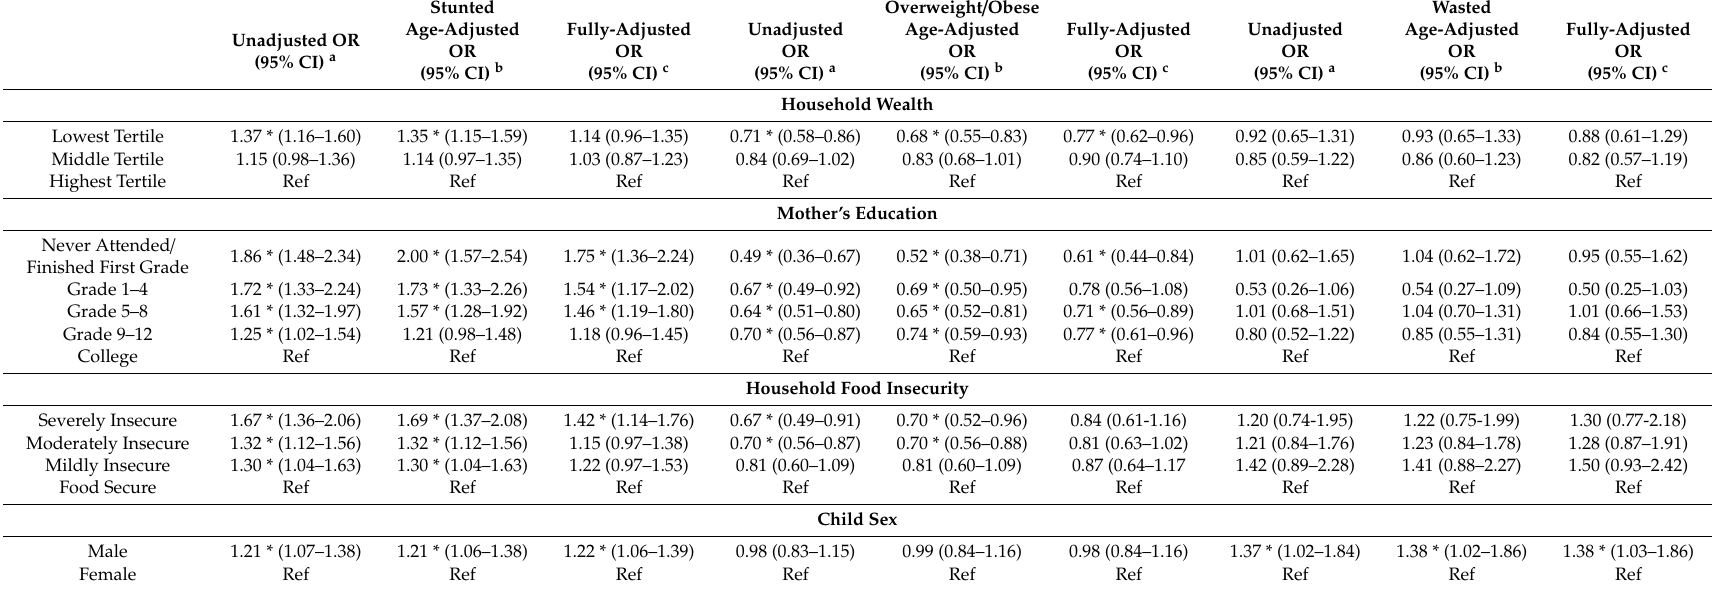
Table 3. Association of socio-economic resources and child malnutrition in Addis Ababa,